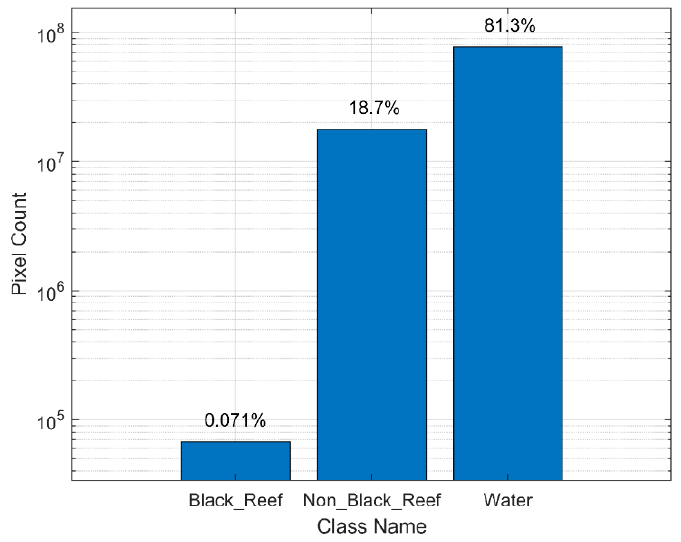
Figure 5. Histogram illustrating the number of pixels used in each of the 3 classes, ‘Black_Reef’, ‘Non_Black_Reef’ and ‘Water’. Table 3. Optimal set of parameters for the 8-layer